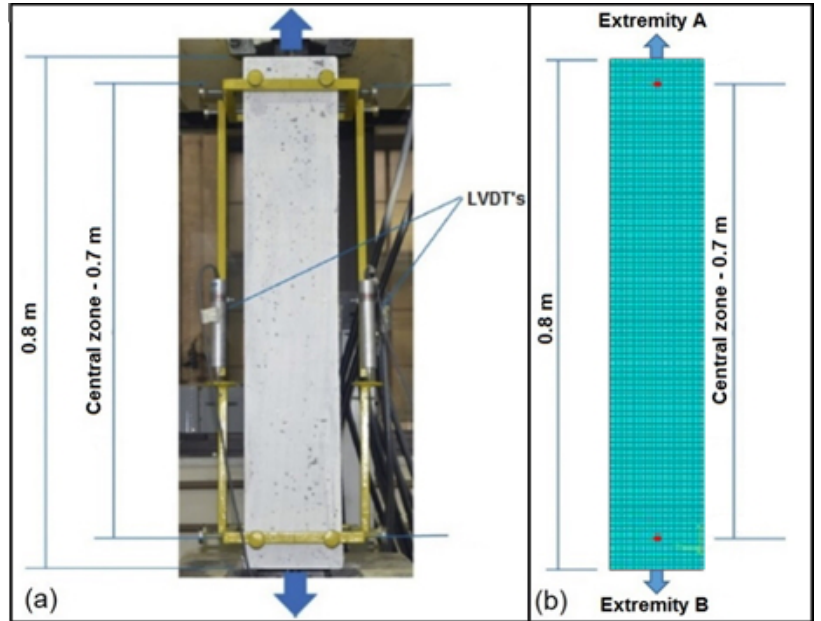
Figure 6. Representation of the reinforced concrete tension stiffening test: a) experimental configuration; b) numerical